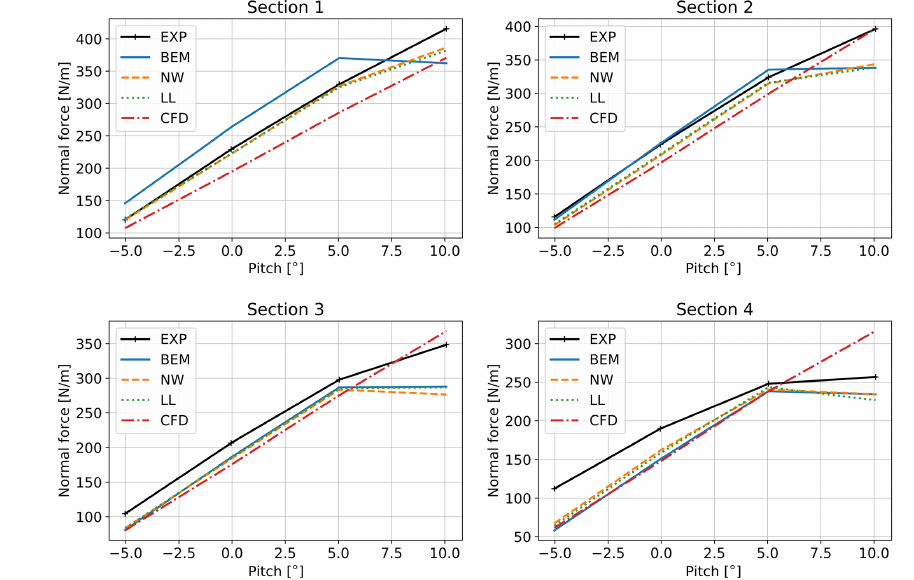
Figure 13. Comparison of normal force from simulations and experiment as a function of pitch angle. Results shown are averaged from four simulations per pitch angle, see Table 2.